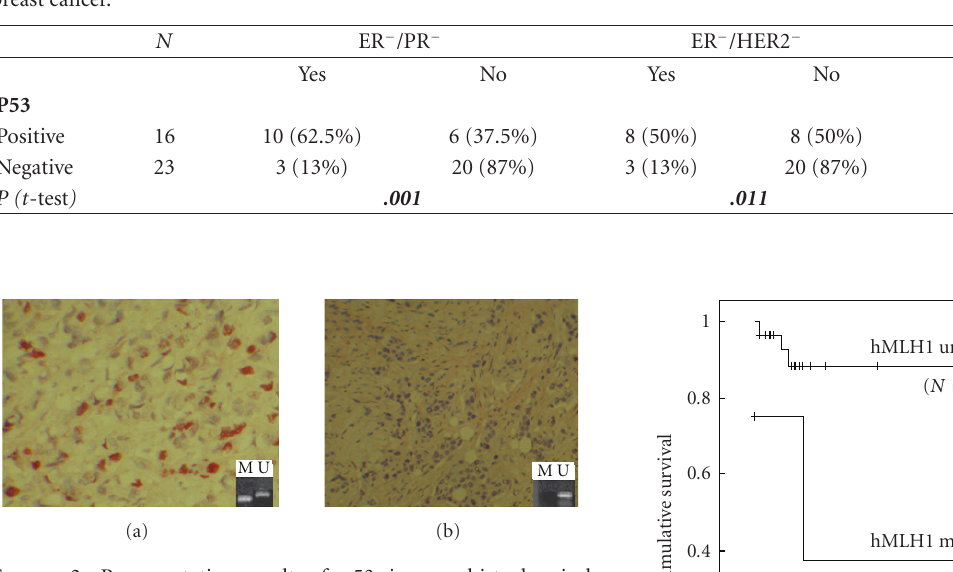
Figure 2: Representative result of p53 immunohistochemical staining and hMLH1 promoter methylation. (a) Breast tumor specimen with p53 nuclear positivity associated with both hMLH1 methylated and unmethylated DNA. (b) Breast tumor specimen negative for p53 correlated with unmethylated hMLH1 profile.